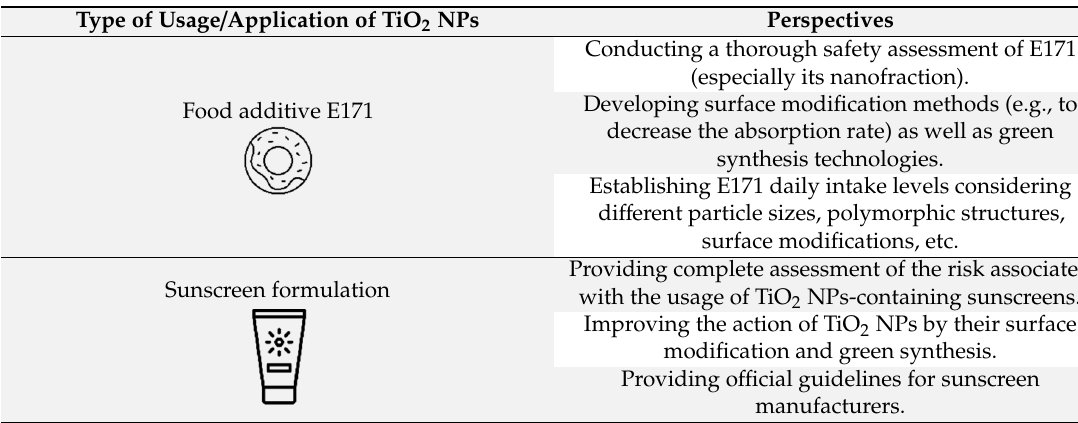
Table 3. Most probable perspectives in future studies regarding the safety of titanium(IV) oxide nanoparticles in everyday products.